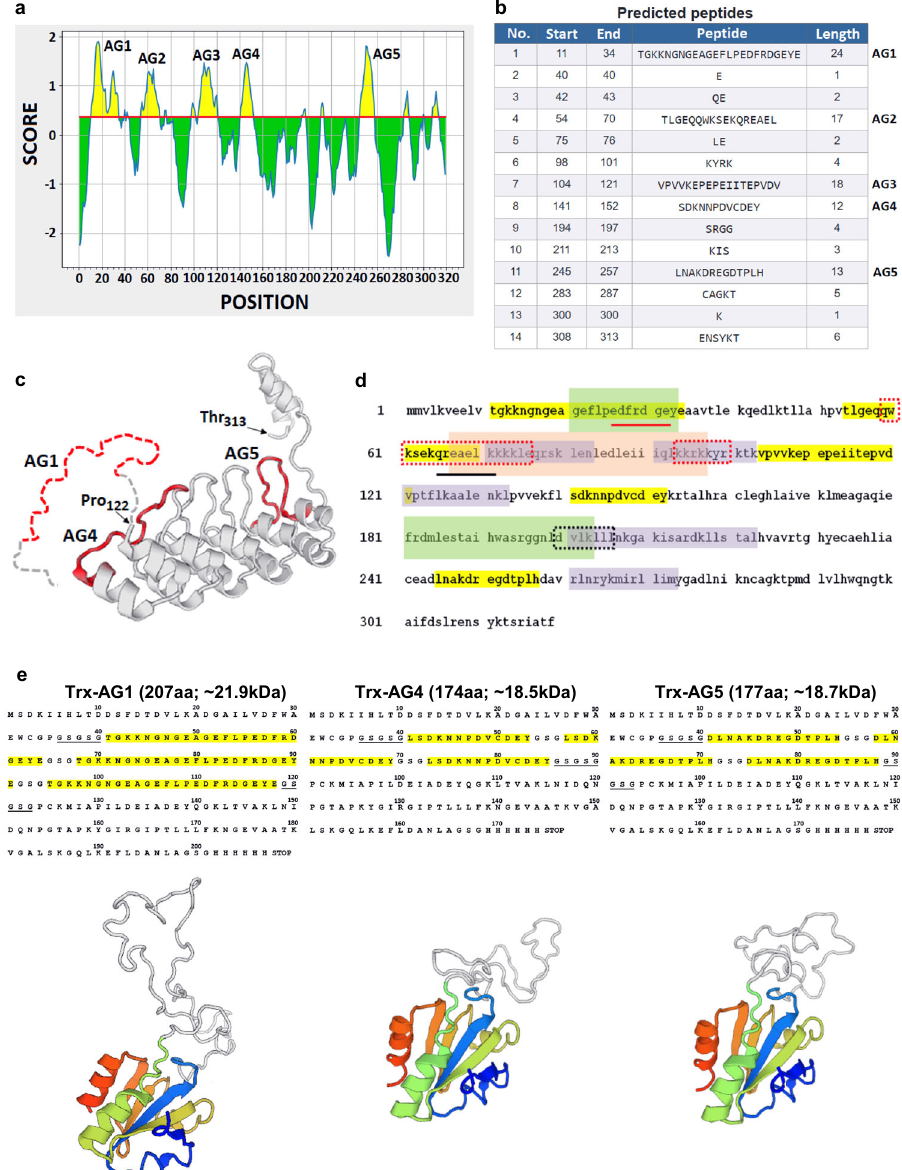
Fig. 2 Peptide selection and antigen design. a Output graph of predicted B-cell linear epitopes showing amino acid position ( x -axis) and Bepipred score ( Y -axis). Residues (yellow) with scores above the default threshold (red line) of 0.35 have a higher probability to be part of an epitope. b Five predicted epitopes (AG1 – AG5) of lengths ≥ 12 amino acids (start and end positions indicated). c Swiss model of hANKRD1 from Pro 122 to Thr 313 using ANK-N5C-281 (PDB entry 4qfv.2.B) as template. Antigen sequences, AG4 and AG5, are shown in red. The sequence upstream of Pro 122 could not be modeled. A schematic representation of this region harboring AG1 is depicted by dotted lines. d Overlay of predicted antigenic sequences (yellow) against titin (green) and calsequestrin (purple) binding sites and the coiled coil region (orange) on hANKRD1. Putative nuclear localization (red dotted boxes), nuclear exporting signals (black dotted box), caspase 3 (red line) and calpain 3 (black line) proteolytic cleavage sites are shown. e Amino acid sequences of Trx- fused immunogens harboring three-copy inserts of antigen sequences (yellow) fl anked by long GSGSG linkers (black underlined). The middle insert is separated from its fl anking counterparts by shorter GSG linkers. The corresponding 3D structure predicted by homology modeling against thioredoxin 1 (1oaz.1.A.) as template are shown below each sequence. The coloured regions correspond to thioredoxin from its amino terminus (deep blue) to its carboxy terminus (red). The regions in white comprise the three-copy peptide inserts and fl anking GSGSG